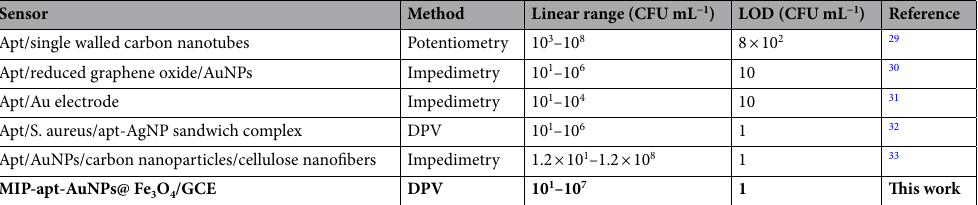
Table 1. Comparison between the proposed aptasensor and other reported sensors for the determination of S. aureus.